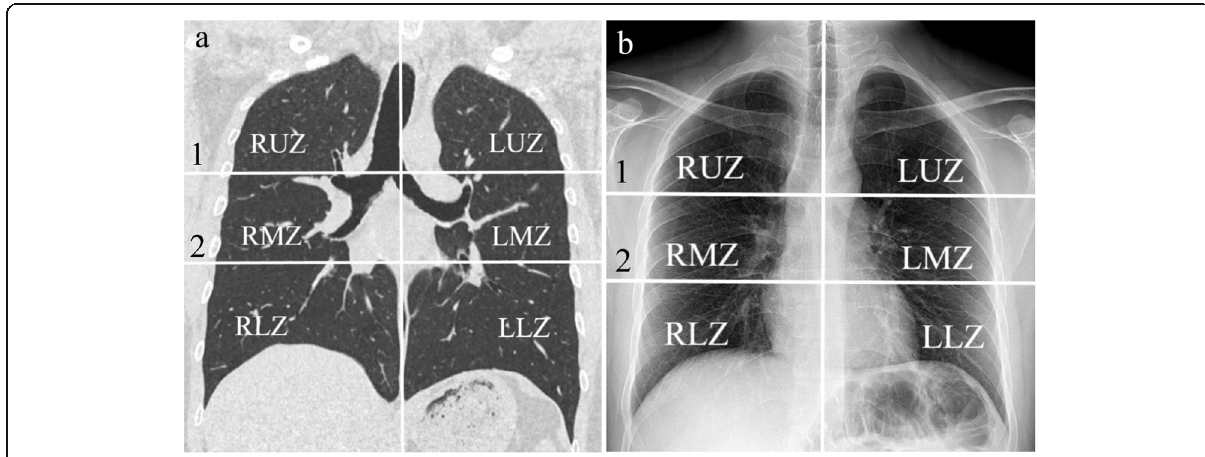
Fig. 2 a , b Lung zones. Two lines, one drawn at the carina level (1) and the other drawn at the level of the inferior wall of the right inferior pulmonary vein (2) divide the lung into 6 zones on both coronal reformatted CT ( a ) and CXR ( b ) images. LLZ left lower zone, LMZ left middle zone, LUZ left upper zone, RLZ right lower zone, RMZ right middle zone, RUZ right upper